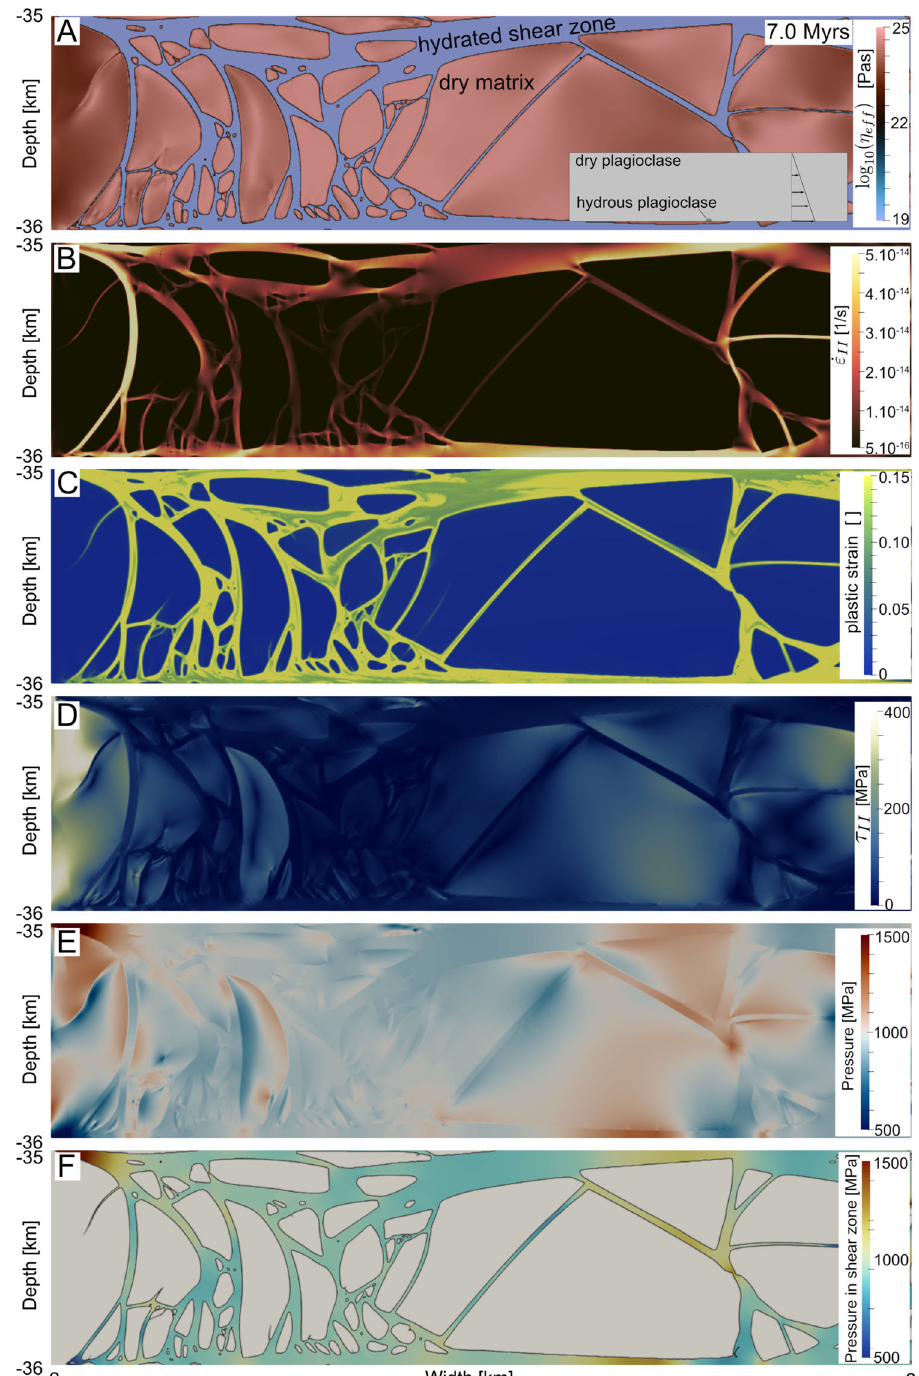
Fig. 2 Numerical simulation of the formation hydrated shear zones in the lower crust. The simulation, using a grid resolution of 4m 2 , started with an initially homogeneous, dry, lower crust (at 650 °C) with a single embedded wet-plagioclase-dominated inclusion (inset in A). When imposing a constant, sinistral shear strain rate of 5 × 10 − 15 s − 1 , brittle shear zones develop, followed by hydrated, weak, shear zones. Shown are snapshots that illustrate A effective viscosity, B second invariant of strain rate tensor, C second invariant of plastic strain, D second invariant of the deviatoric stress tensor, E dynamic pressure, and F detail of dynamic pressure within the shear zones. Complex shear zone patterns emerge that have signi fi cant variations in stresses and dynamic pressures and may explain the coexistence of high and lower pressure assemblages in the same rocks. See Supplementary Movies S1 – 4 (Supplementary Notes 3) for animation and (Fig. S1, Supplementary Notes 2; Fig. S7, Supplementary Notes 4) for the temporal evolution for a range of imposed strain